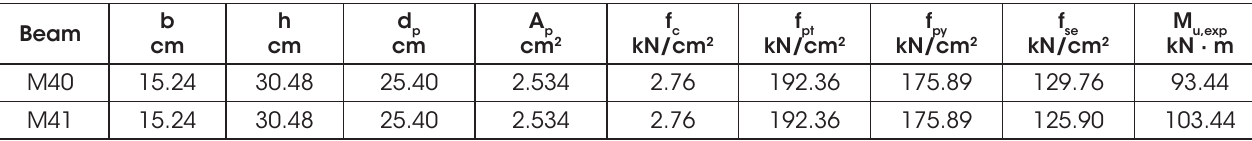
Data of the beams tested by MATTOCK